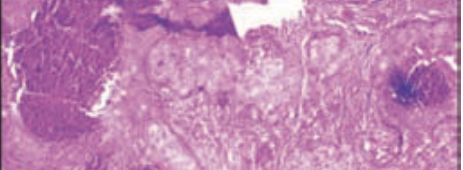
Fig.3. Solid carcinoma – neoplastic cells seen as solid sheets inside duct without any lumen (H&Ex100)